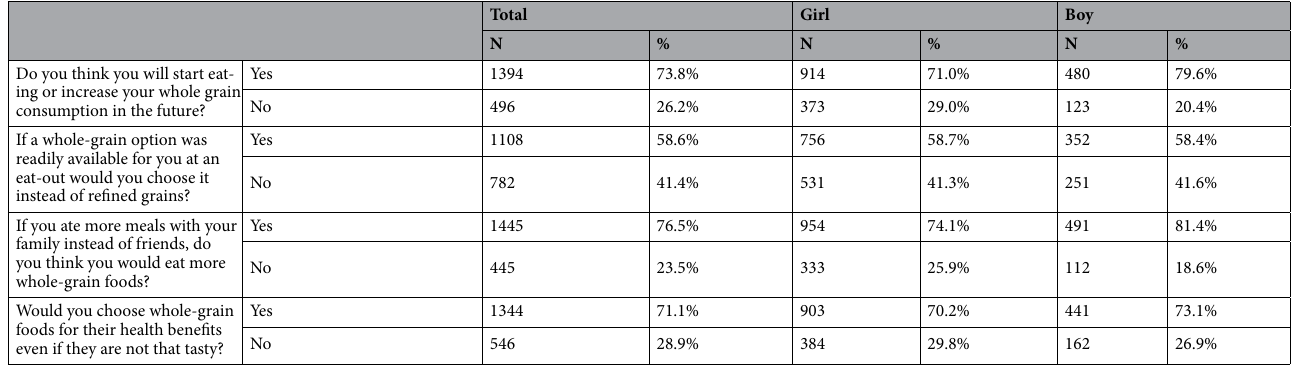
Table 2. Information obtained from the whole grain barriers questionnaire.